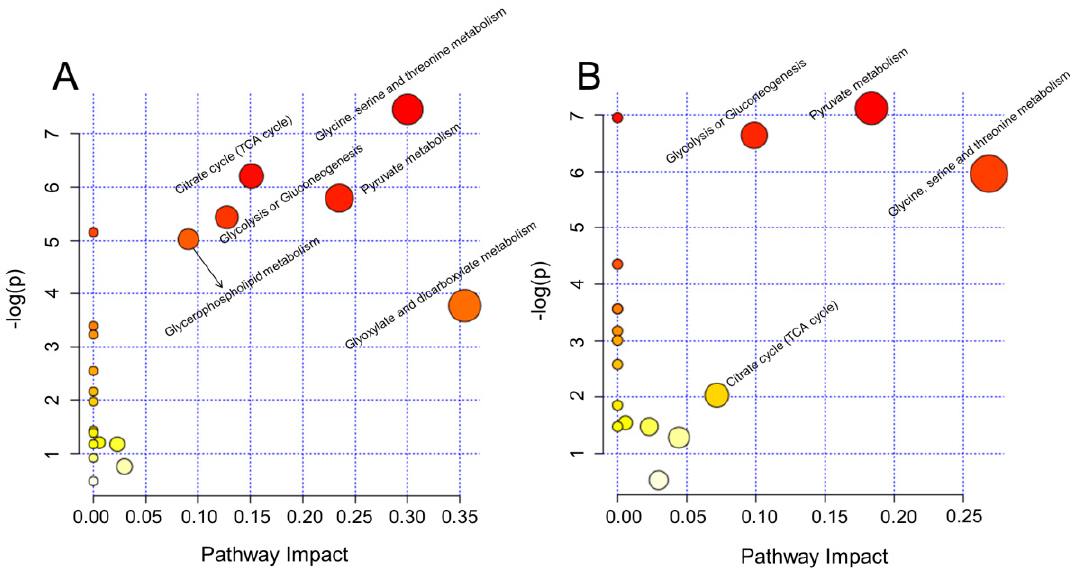
Figure 4. Summary of pathway analysis using MetaboAnalyst 4.0; ( A ) metalaxyl-M treatment group; ( B ) rac- metalaxyl treatment group.